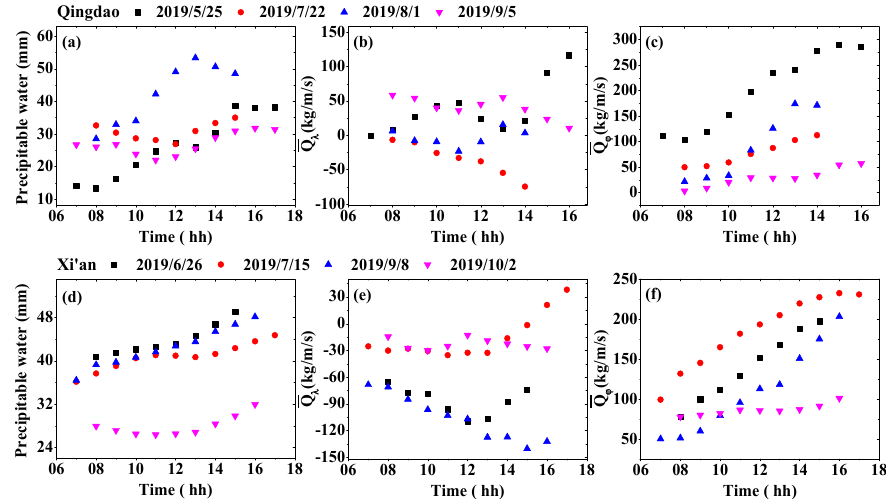
Figure 15. PW and vertically integrated WVFs before precipitation: ( a – c ) PW and the zonal and meridional vertically integrated water vapor transport fluxes in Qingdao, respectively; ( d – f ) PW and the zonal and meridional vertically integrated water vapor transport fluxes in Xi’an, respec- tively.